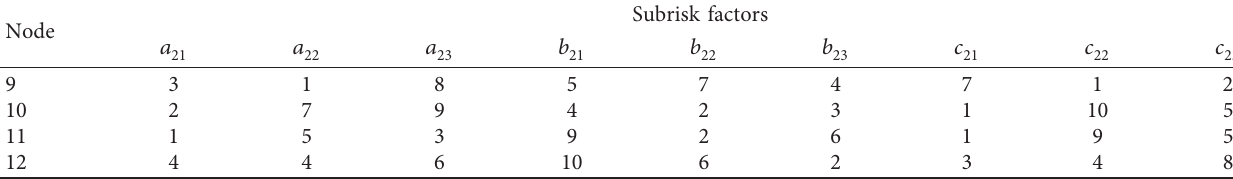
Table 8: Scoring results of subrisk factors of the second-level nodes.